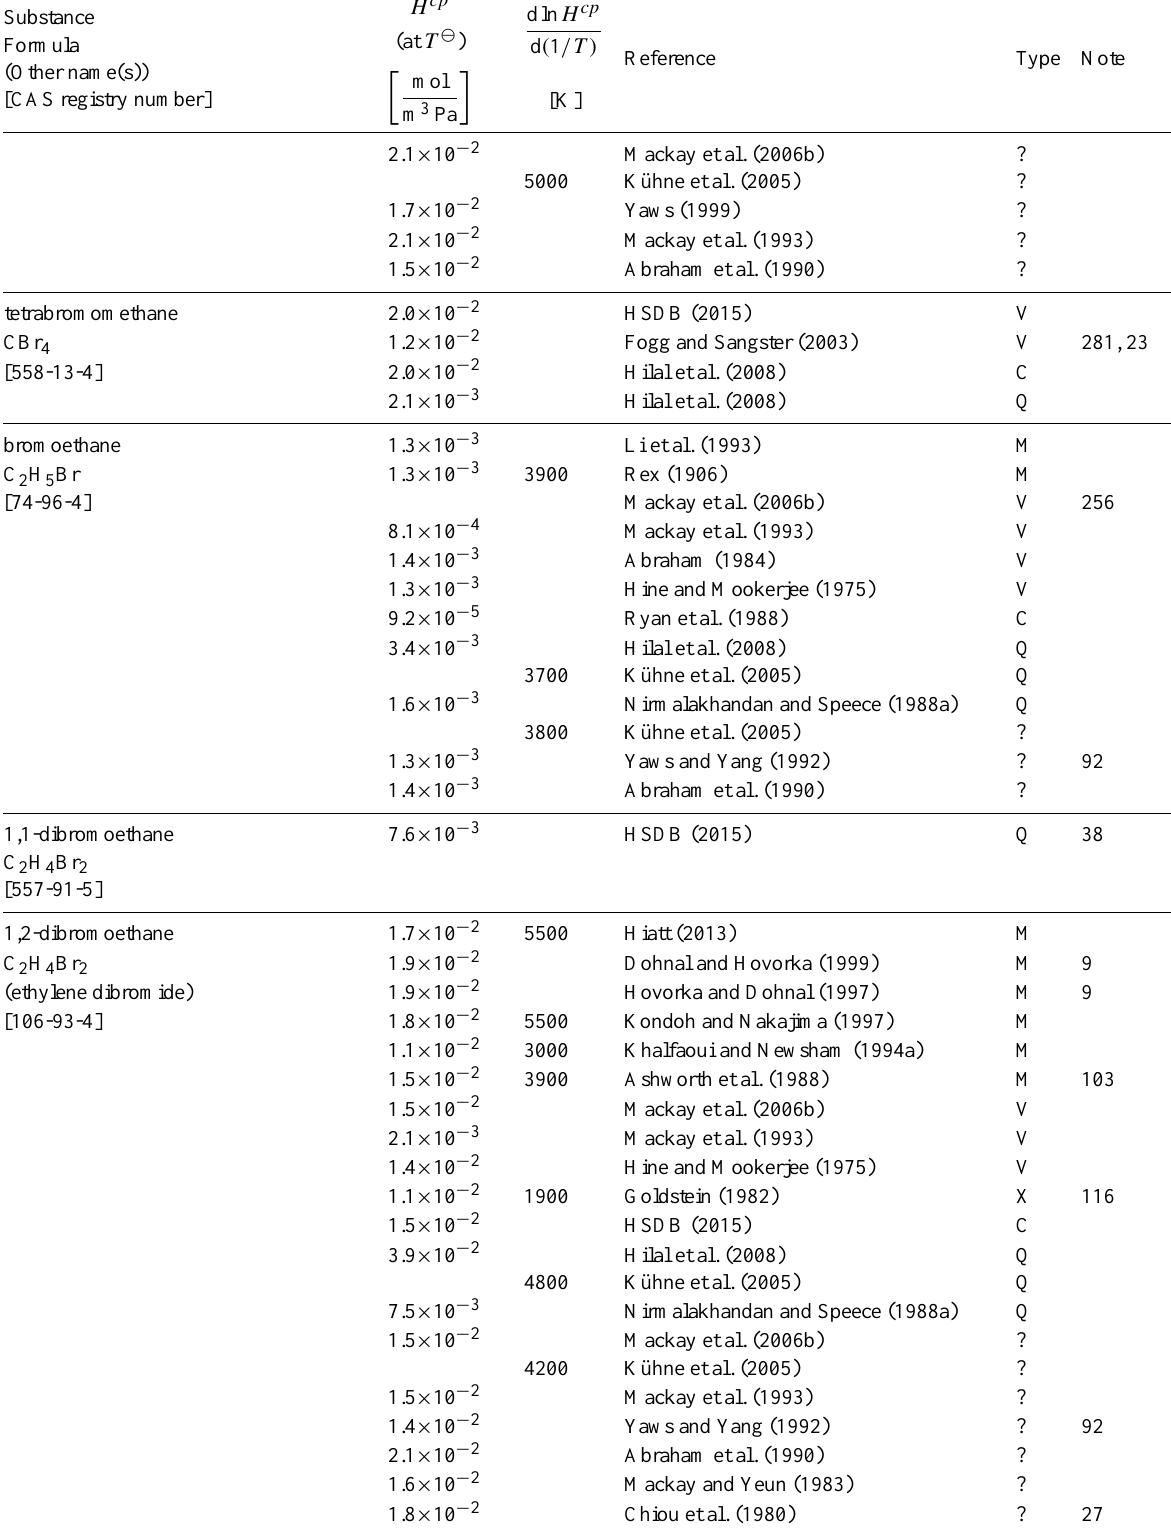
Table 6: Henry’s law constants for water as solvent